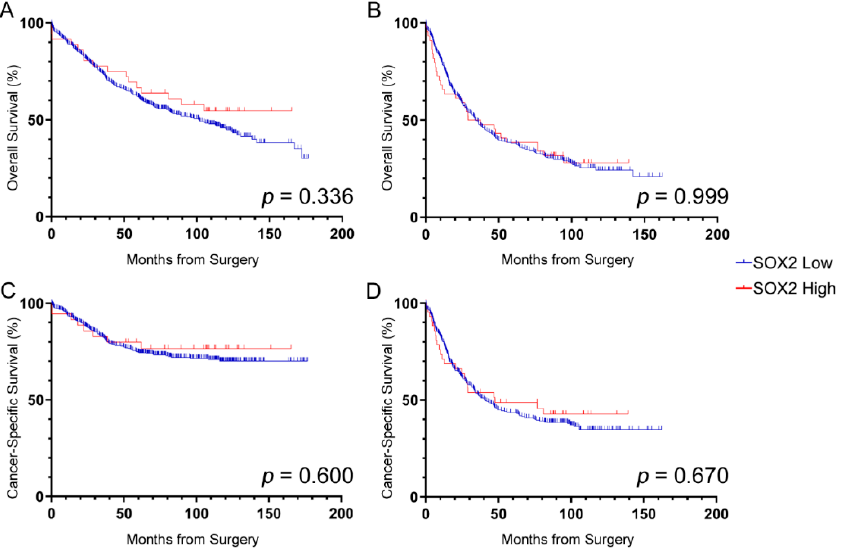
Figure 2. Prognostic value of SOX2 + cell densities. Overall survival ( A , B ) and cancer-specific survival ( C , D ) for patients with (a,c) stage II and (b,d) stage III CRC based on SOX2 expression. No significant associations between SOX2 density and survival were found. Log-rank p -values shown.